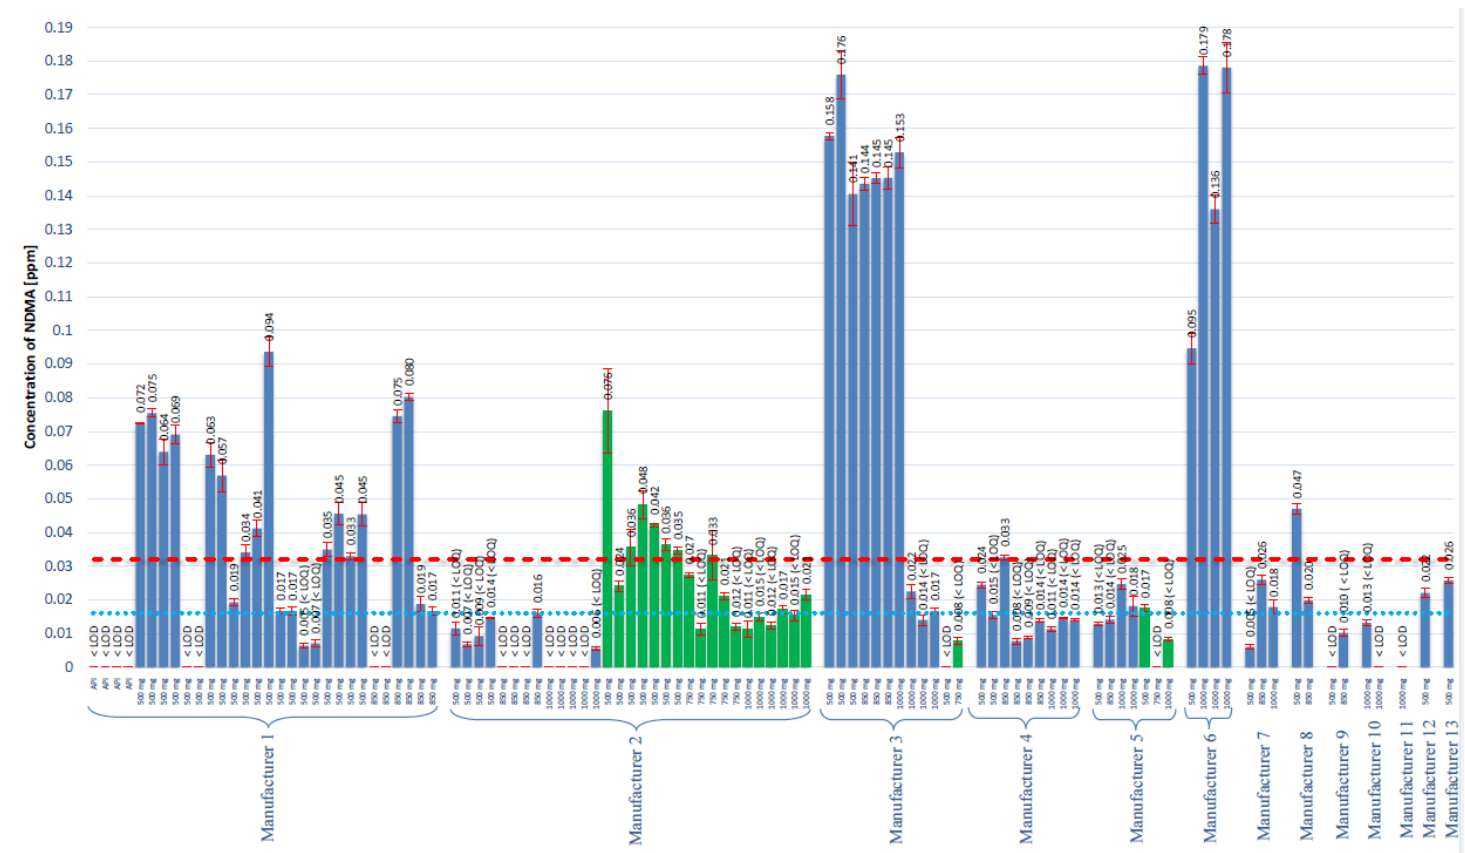
Figure 3. The results of the assay of NDMA concentration in all tested metformin products. Blue bars represent finished products, and the green bars corresponds to the prolonged finished products. The red dotted line represents the suggested maximum allowed concentration of 0.032 ppm. The blue dotted line represents the LOQ of the method that corresponds to 0.016